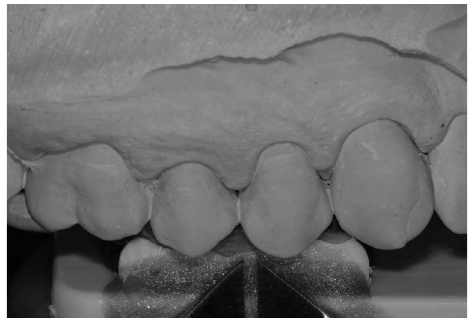
Figure 4. Cast photograph following the same standardization used intra-orally. The respective radiographic positioner was positioned over each cast. The area measurements from intra-oral photographs ( Baseline ) was compared with those obtained on the casts photographs of each respective